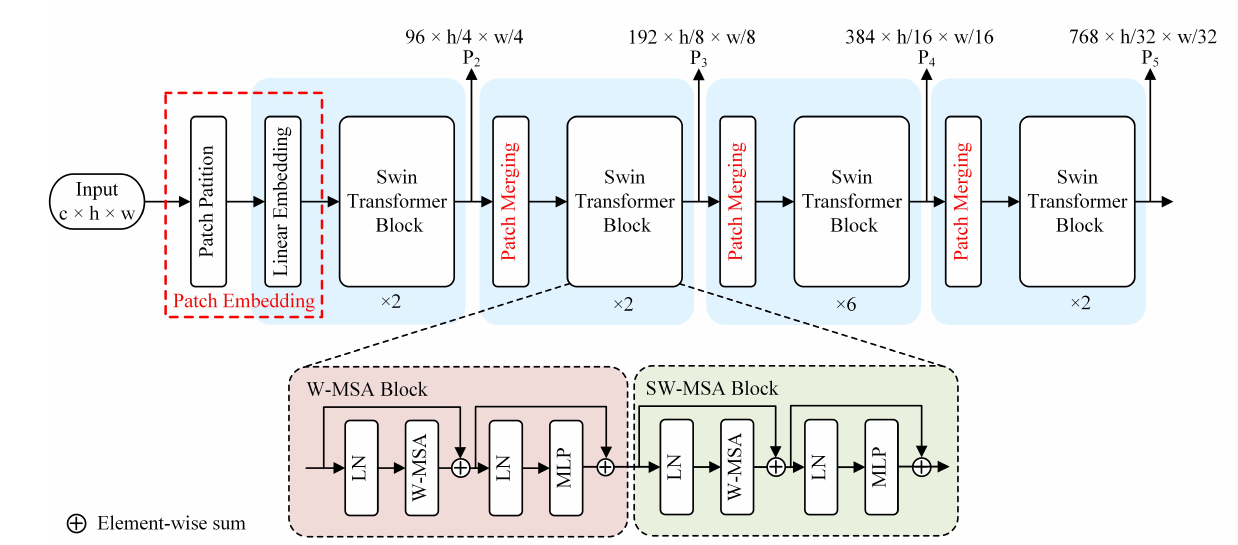
Figure 4. The Swin Transformer architecture.